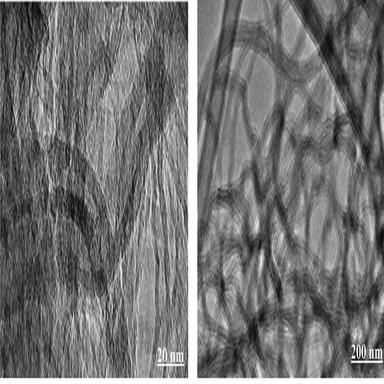
High resolution transmission electron microscope analysis.